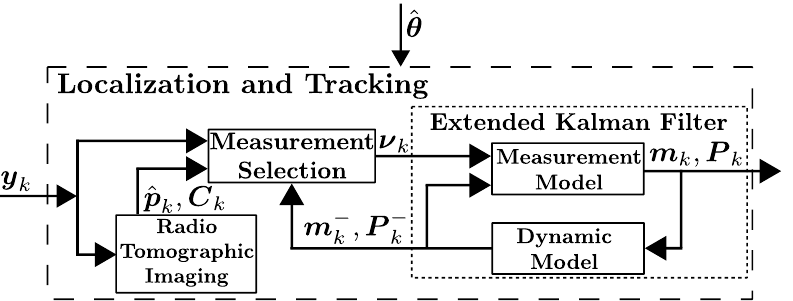
Figure 3. Major components of the proposed localization-and-tracking method. The notation is introduced in Sections 3 and